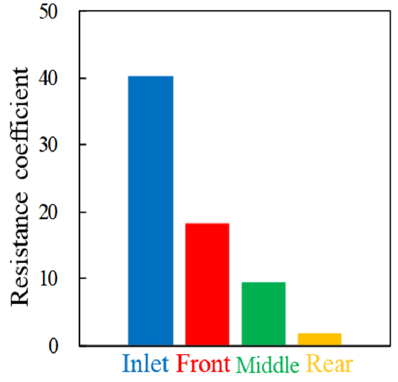
Figure 12. Distribution of the Resistance coefficient at different positions.